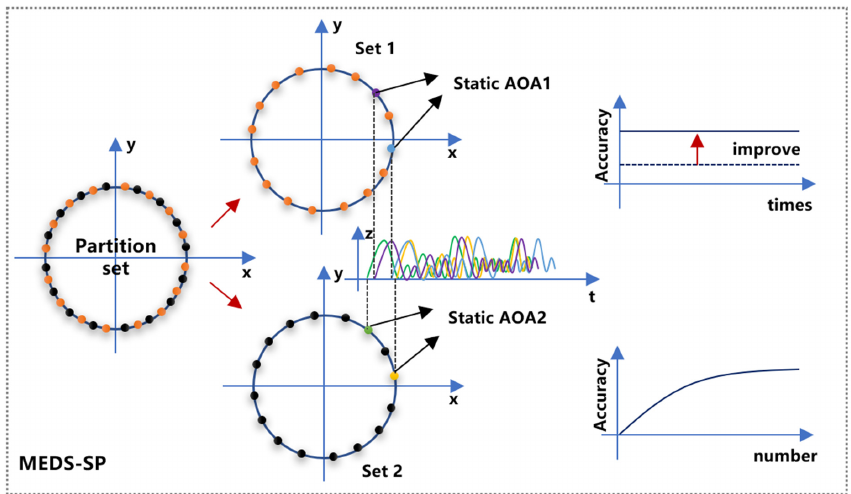
Figure 5. The models and performance of MEDS-SP.